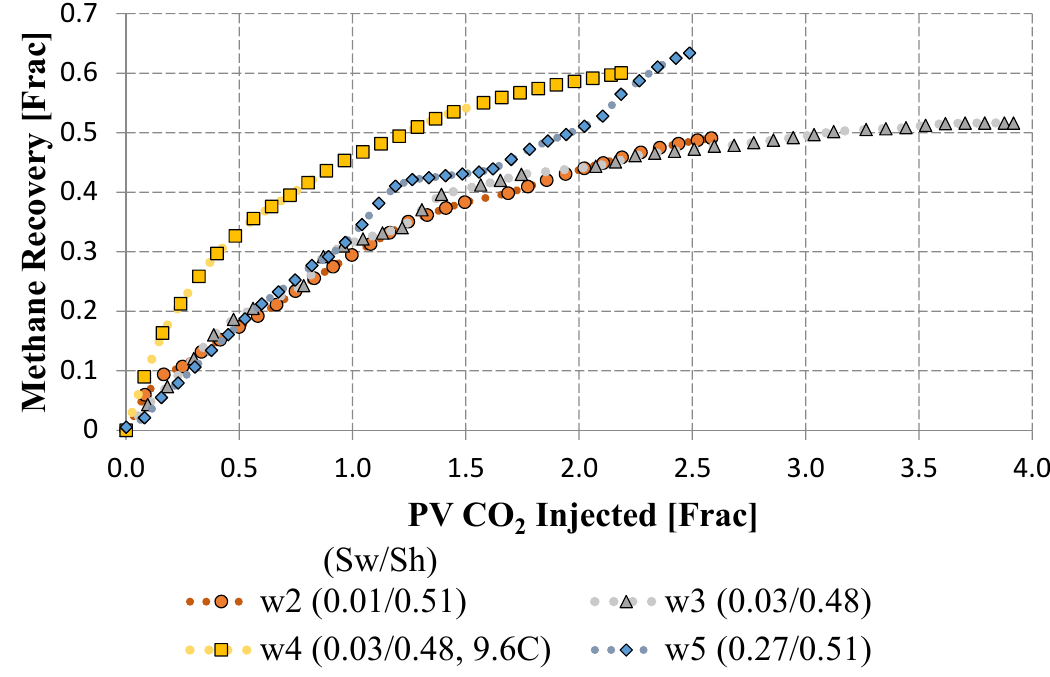
Figure 12. CH 4 recovery during constant CO 2 injection at 1.2 cm 3 /h over a 200 h period